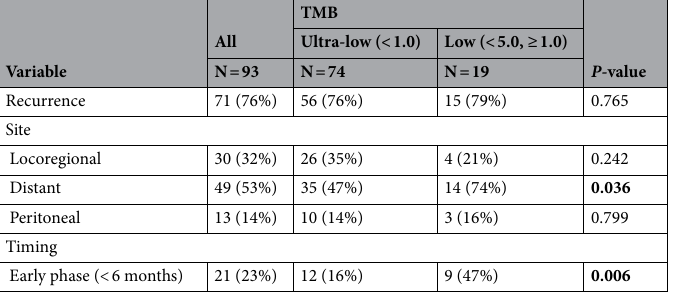
Table 4. Sites of recurrence according to TMB in pancreatic cancer patients who underwent surgical resection. BR borderline resectable, R resectable, Ph pancreatic head, Pbt pancreatic body and tail, TMB tumor mutation burden. Significant values are in